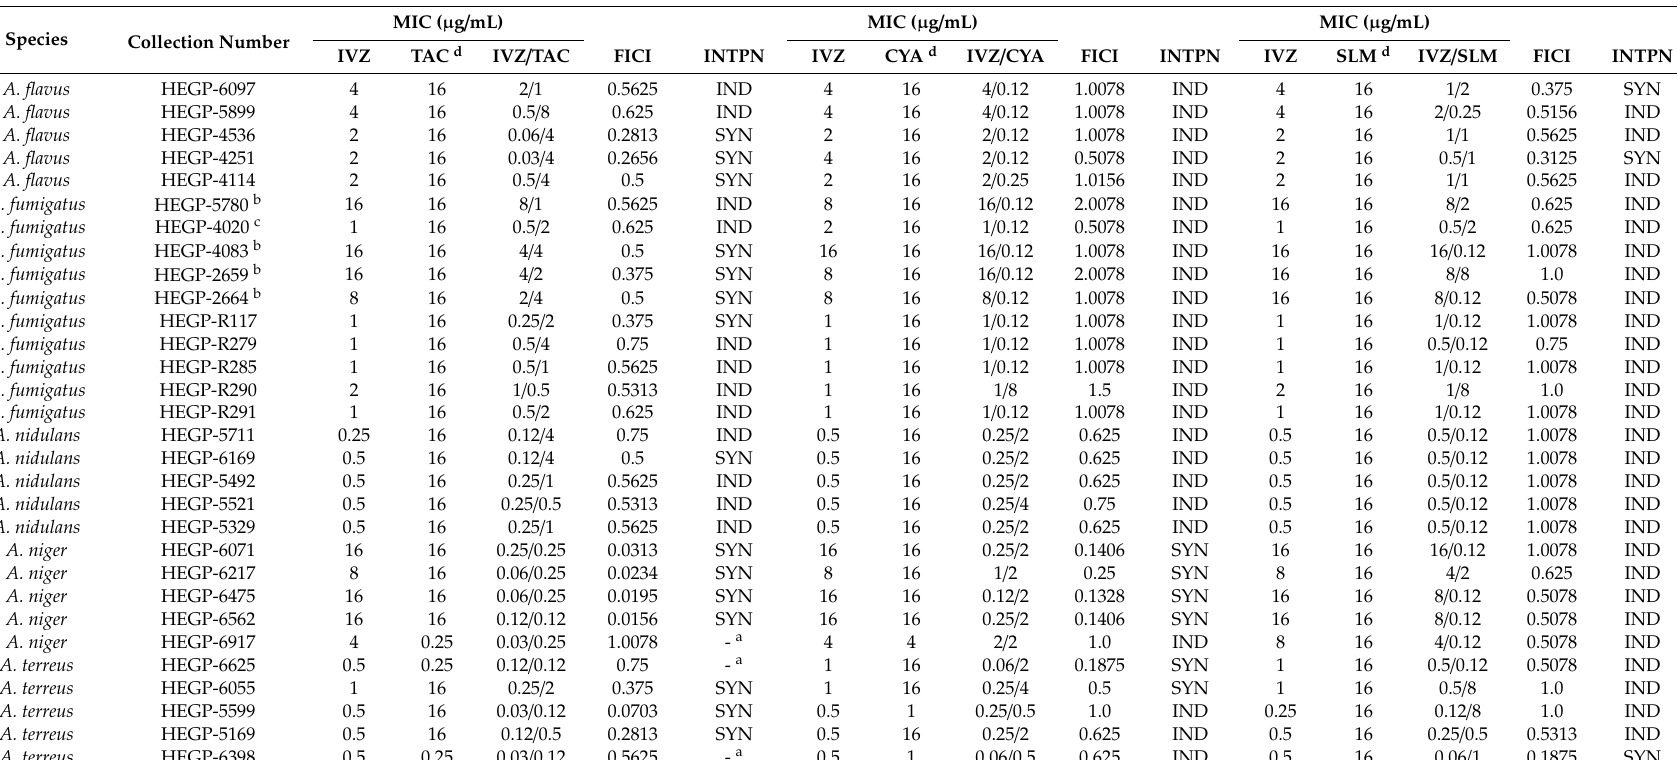
Table 1. Interaction of isavuconazole with tacrolimus, cyclosporin A, or sirolimus against Aspergillus